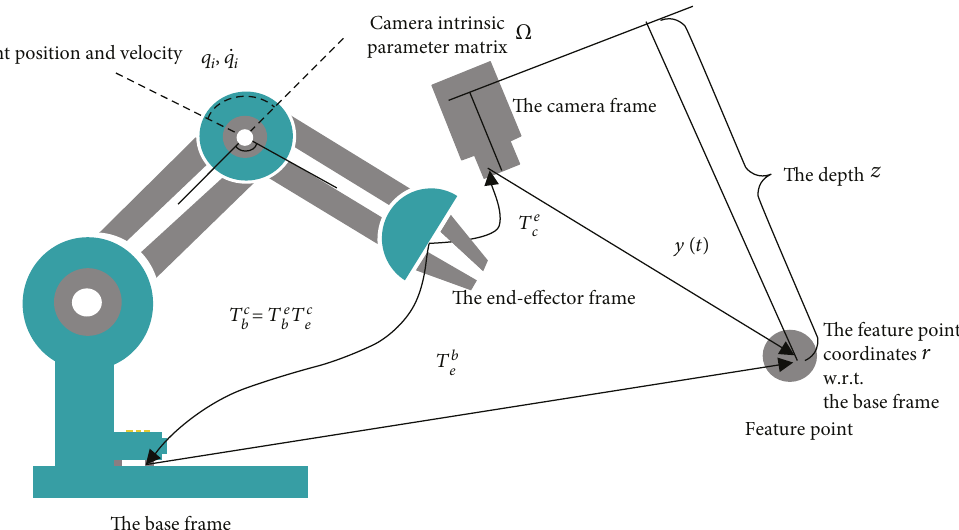
Figure 2: Robotic system with the eye-in-hand con fi